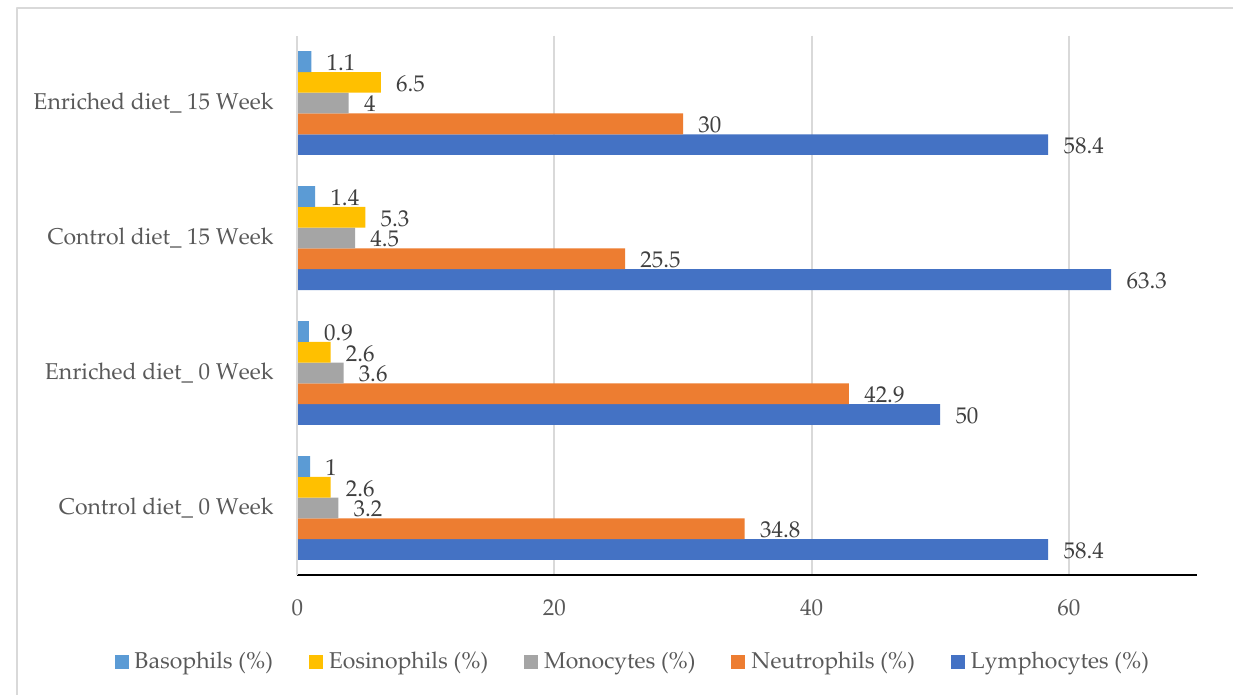
Figure 2. Percentage of lymphocytes, neutrophils, monocytes, eosinophils and basophils for Control and Enriched diets at 0 and 15 weeks.